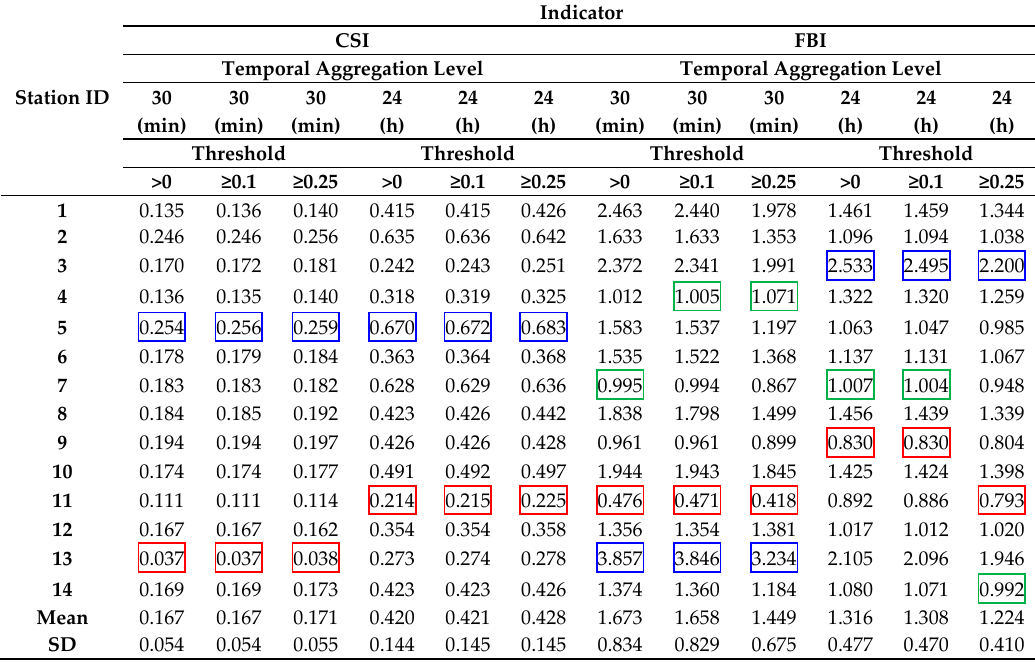
Table 6. Results of the precipitation detection capacity analysis (CSI and FBI).